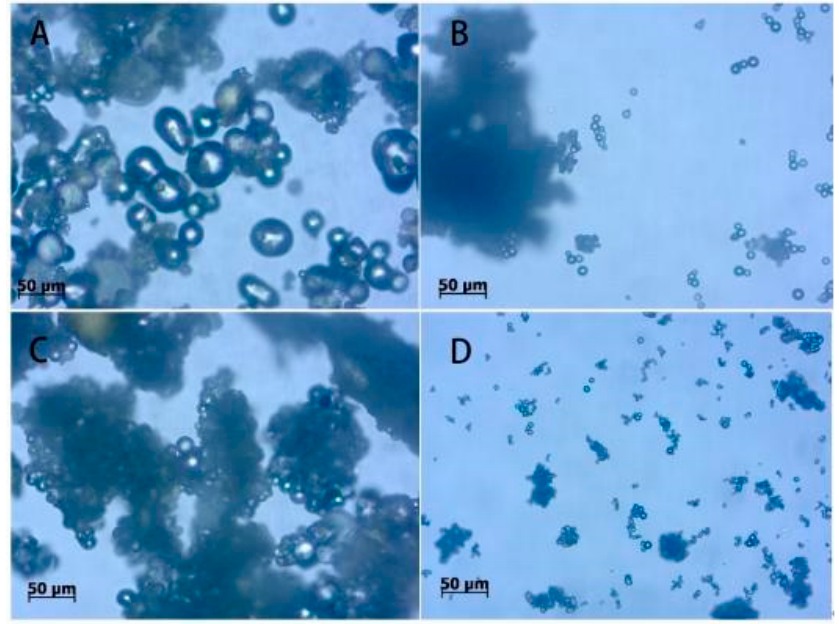
Figure 2. Microscopic morphology of orthogonal test products: ( A ) sample 1, ( B ) sample 2, ( C ) sample 3, ( D ) sample 4.